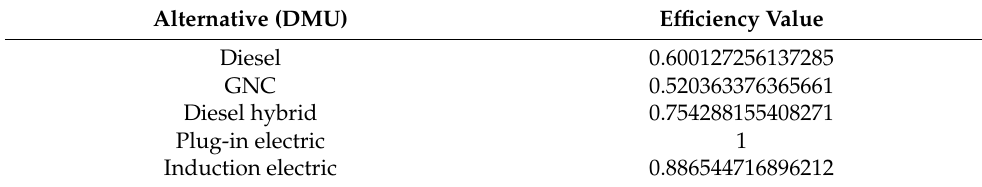
Table 5. Maximum efficiency of motors with “Set 2 of restrictions”.